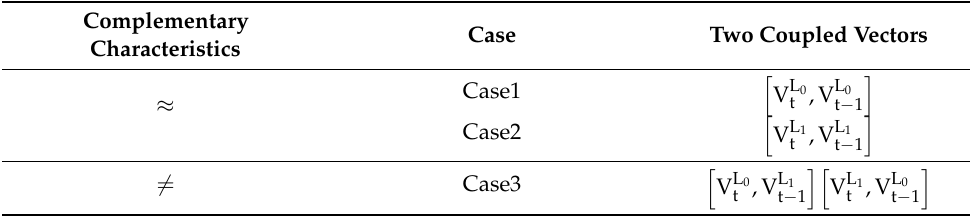
Table 1. Cases and Complementary